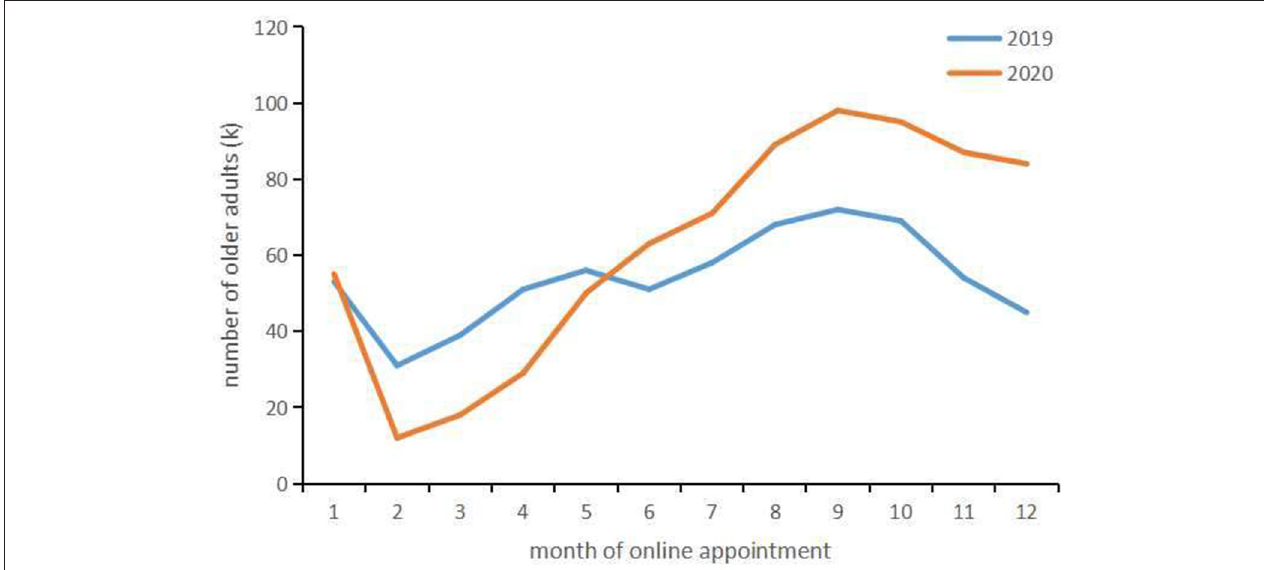
FIGURE 1 | Trend in the number of older adults using online appointment in 2019 and